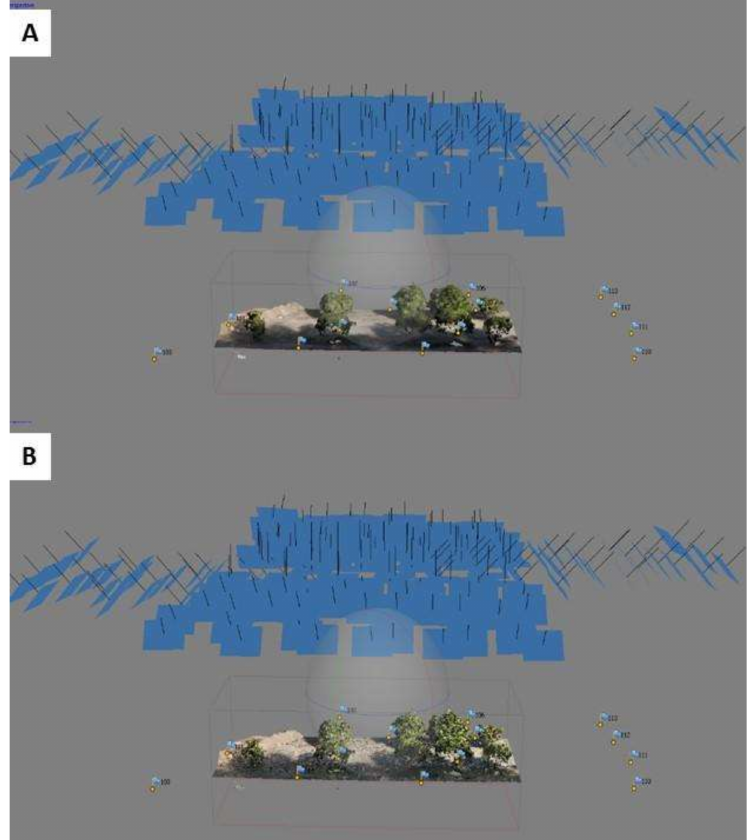
Figure 8. Model from UAV: ( A ) Mesh; ( B )